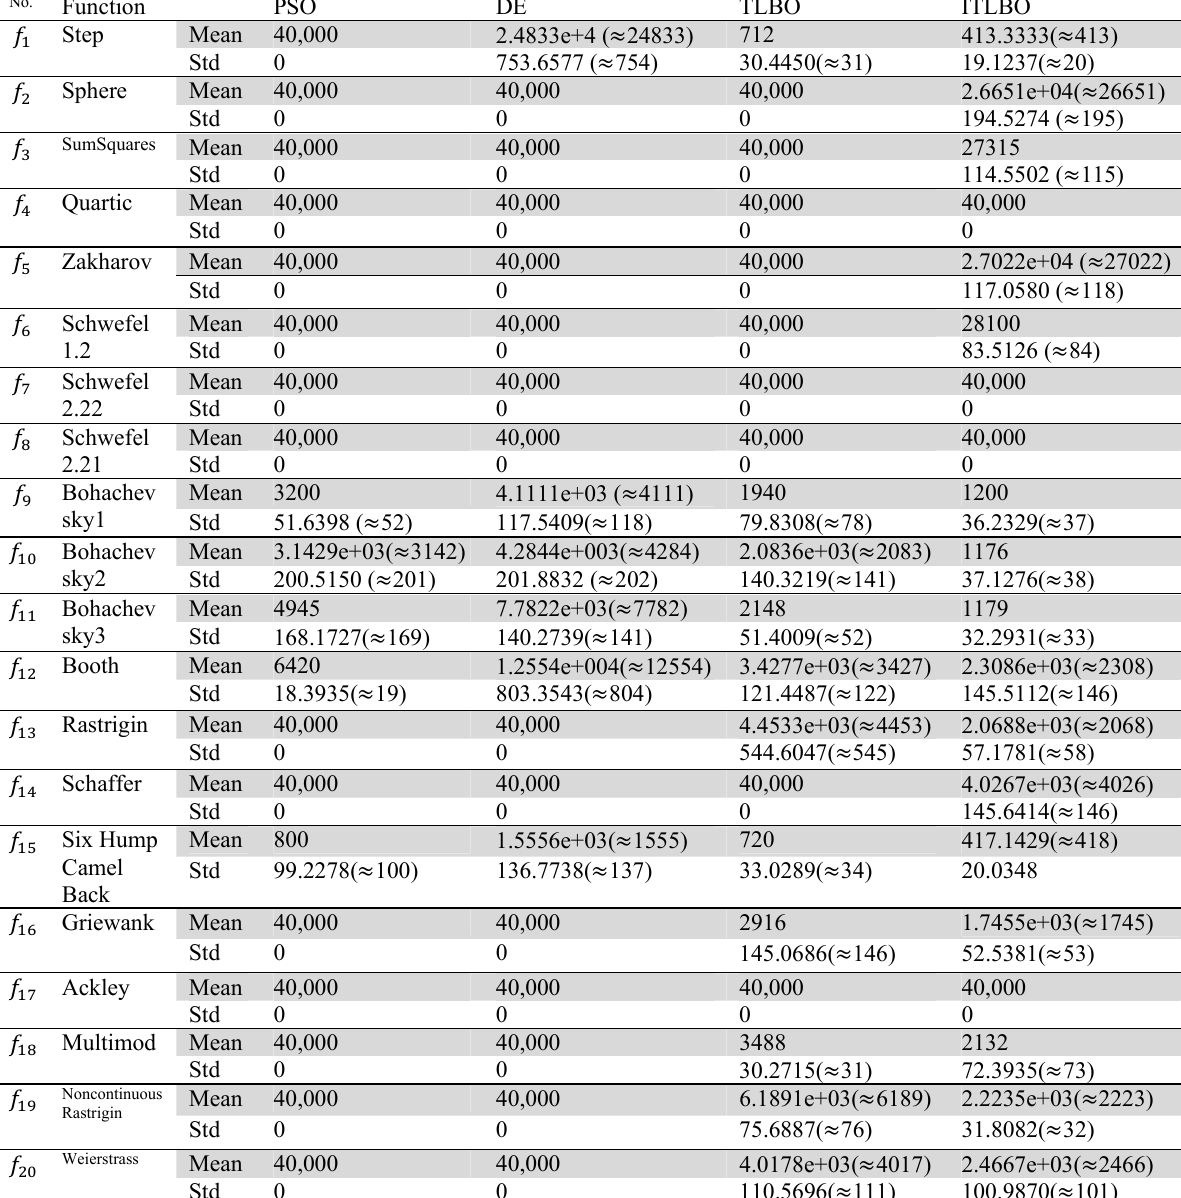
Table 3 No. of fitness evaluation comparisons of PSO, DE, TLBO, ITLBO No. Function